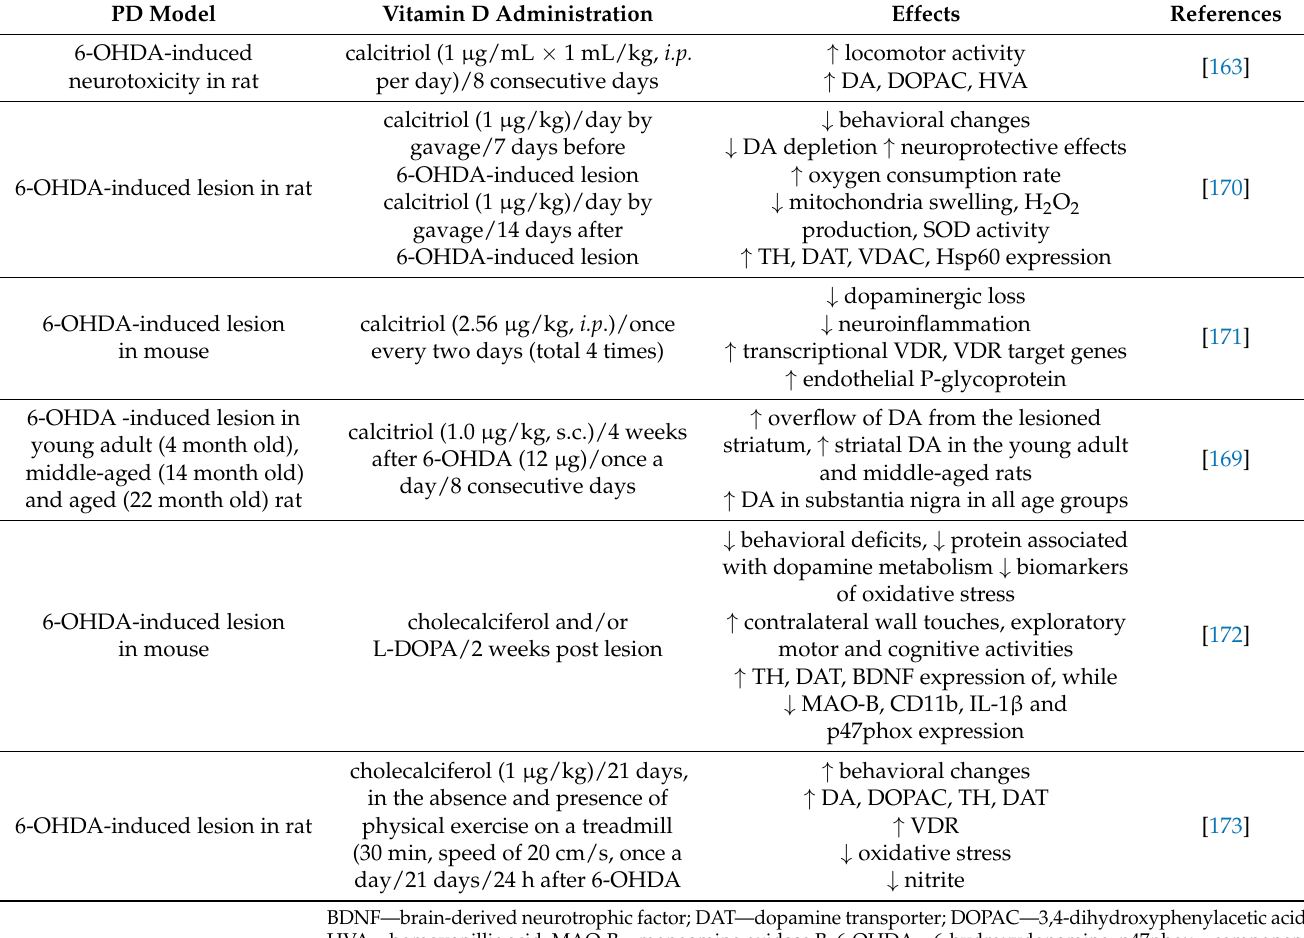
Table 4. Effects of vitamin D in experimental models of Parkinson’s disease—in vivo